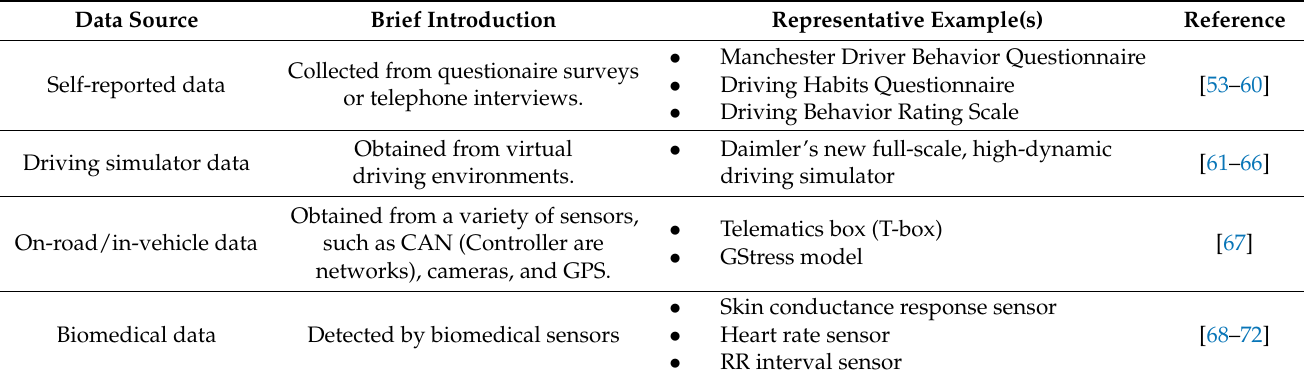
Table 2. Four main data for evaluating older people’s driving behavior and stress. Data